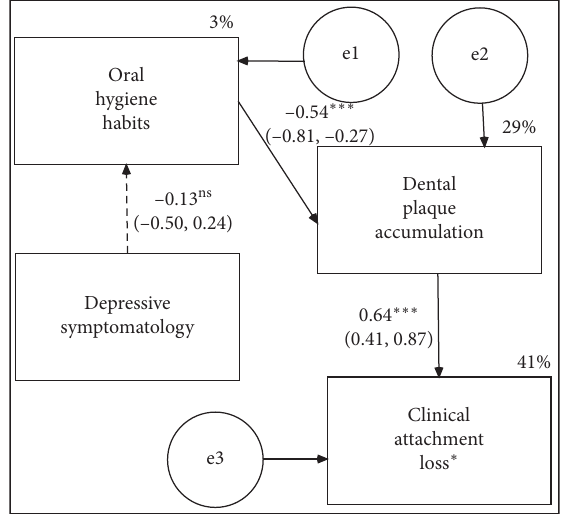
Figure 4: Maximum-likelihood parameter point estimates and 95% Monte Carlo confidence intervals (with 10,000 bootstrap samples) in the general population sample of 29 participants. ∗ The squared clinical attachment loss scores were used, since this mathematical transformation improved their fit to normal